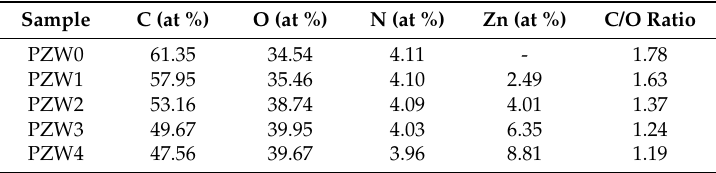
Figure 4. Survey XPS spectra of PZW0 and PZW4 ( a ); C 1s ( b ); O 1s ( c ); and Zn 2p ( d ). Table 1. Element content and C/O ratios of the PE/ZnO/wood-fiber composite.